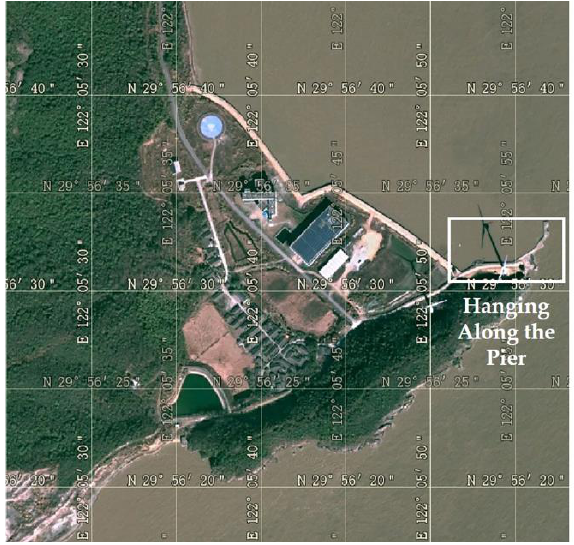
Figure 2. Selection of suspension position at the Zhai Ruo Shan Island. Zhai Ruo Shan Island is located in the middle of Zhoushan Fishing Ground, Zhejiang Province, 29°56′ N, 122°5′ E, with a distance of 8 km from the seaport. It has a 7.27 km long coastline, an area of 2.7 km 2 , a marine monsoon climate on the southern edge of the north- ern subtropical zone, annual average temperatures of 16 °C, and humid climates [42,43]. The wharf is rich in biomass, with a suitable water depth (Figure 3). The wave scouring is strong, which is suitable for testing the attachment of biological organisms and seawater erosion resistance test of concrete test blocks in the marine environment.